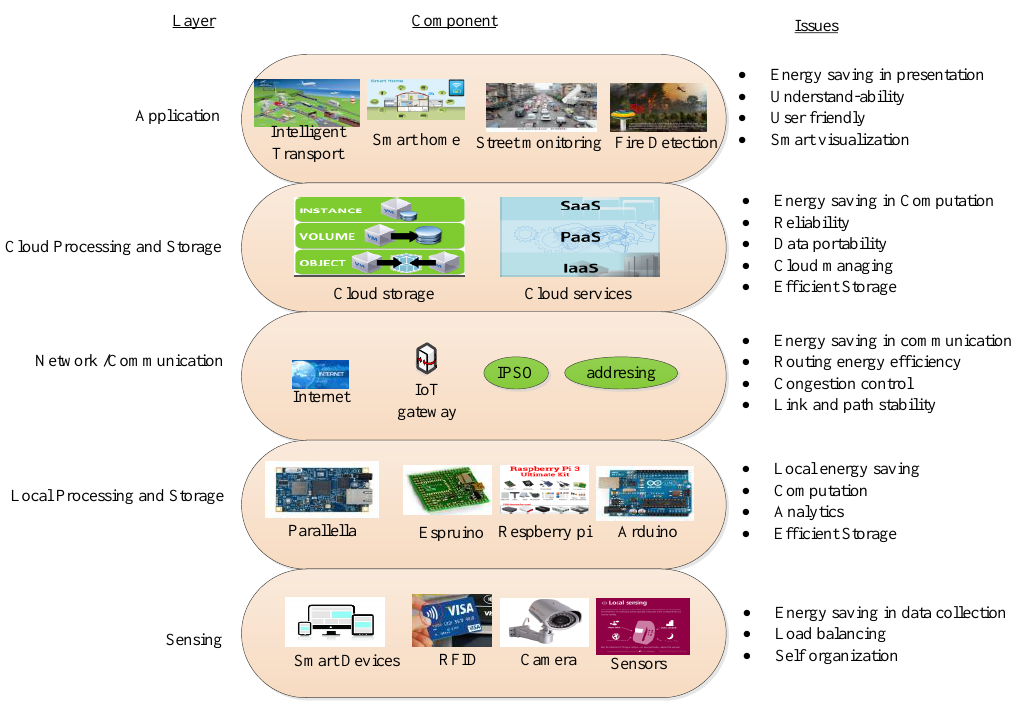
Figure 1. Energy consumption-oriented layered architecture for IoT.